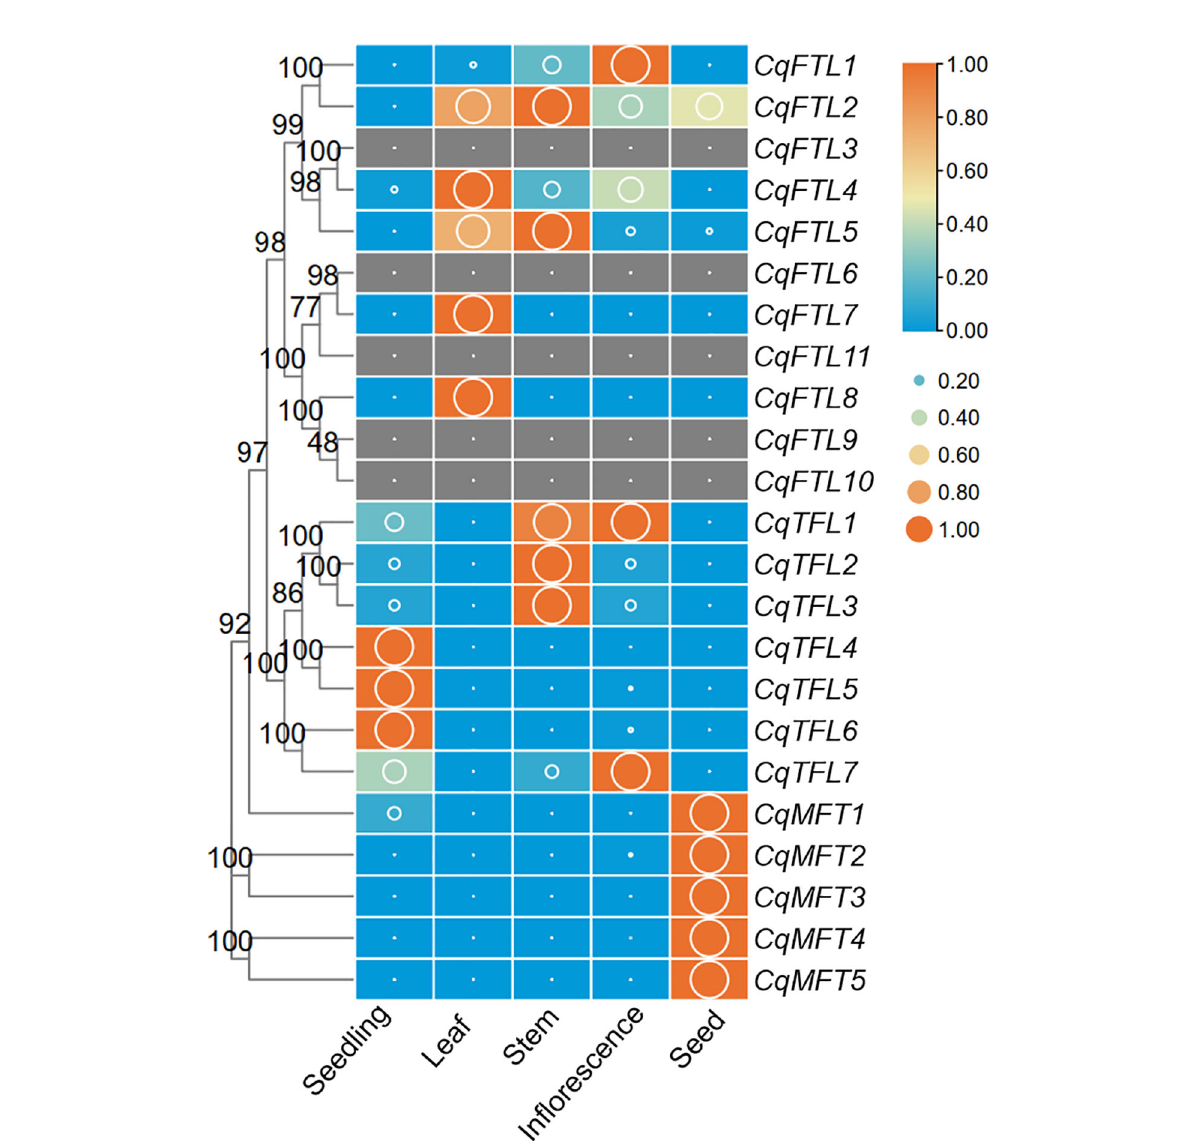
FIGURE 7 Expression pro fi les of PEBP genes in 5 quinoa tissues. The expression value is denoted by FPKM values (cutoff=0.1) generated by using the RNA- seq data from Zou et al. (Zou et al., 2017). Each expression value was generated from three replicates. Orange boxes with larger-size bubbles indicate higher expression levels. Expressions in various tissues of the same gene were normalized to 0 to 1 by